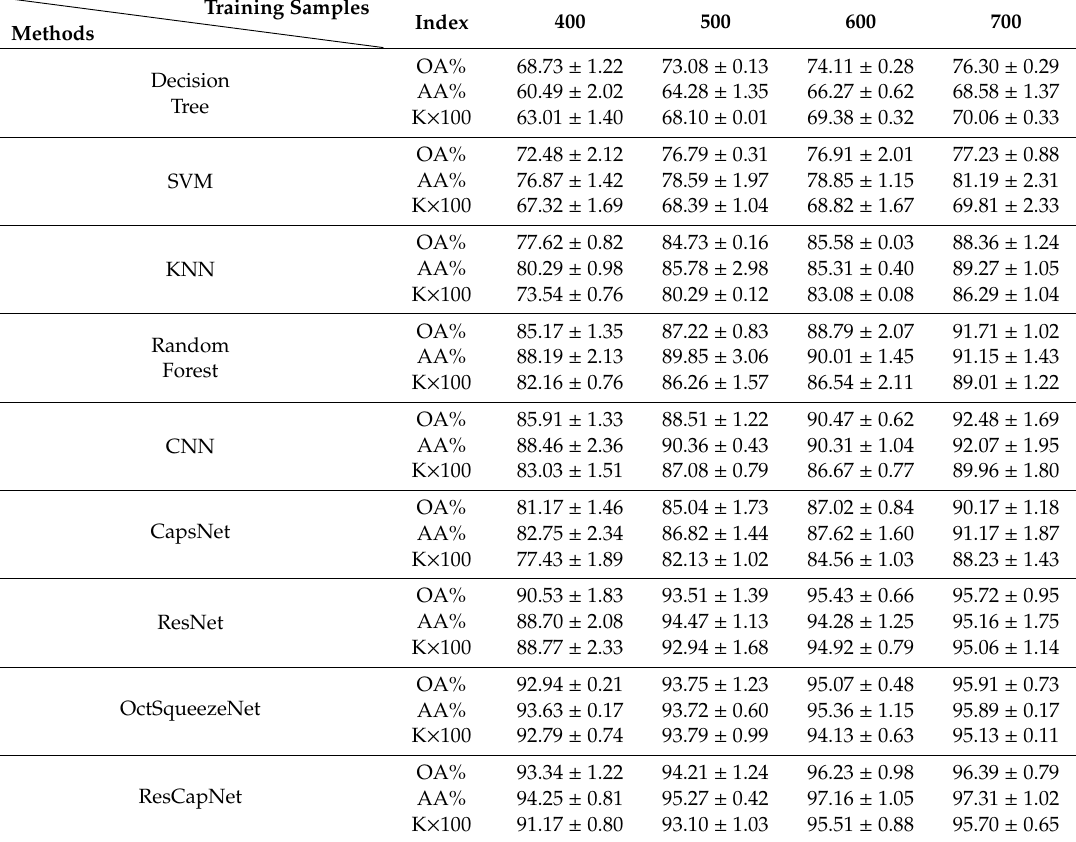
Table 3. Classification results of di ff erent training samples on Recology data